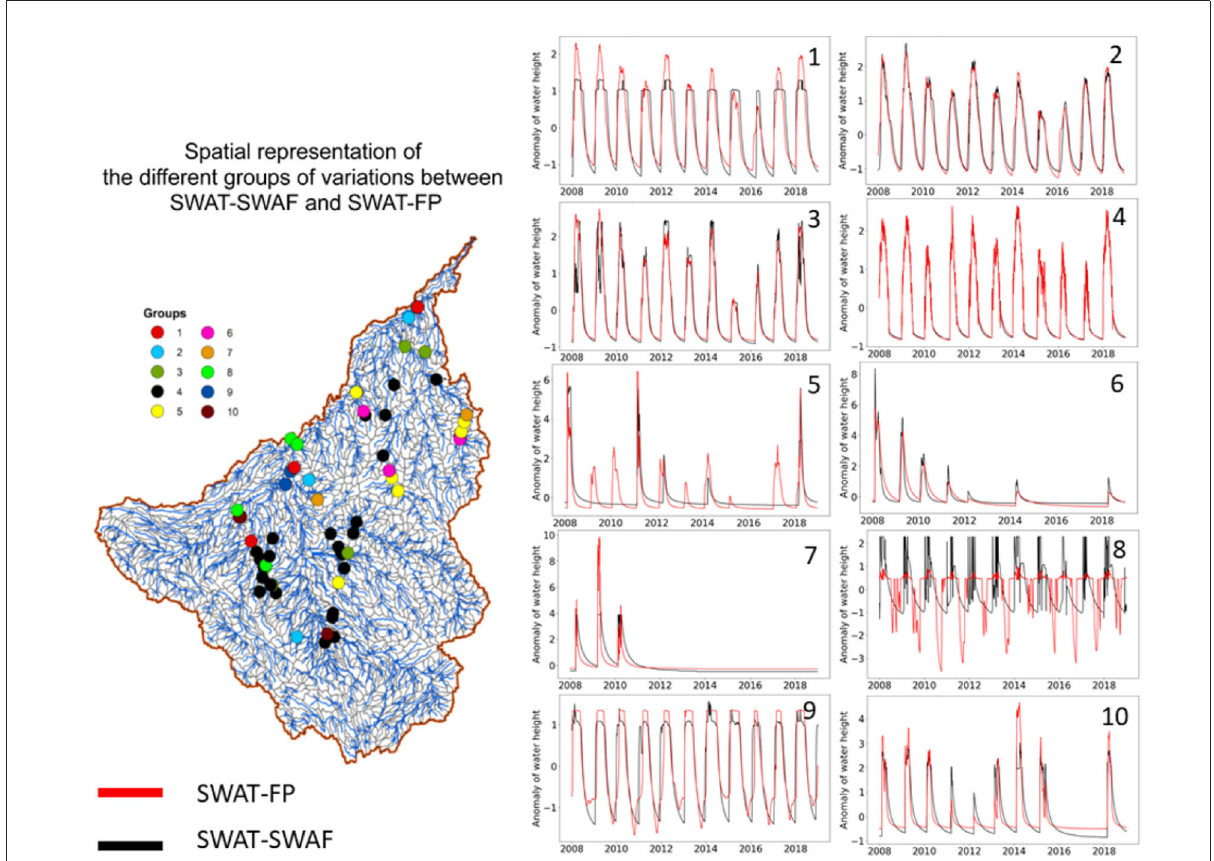
FIGURE10 (Left) Spatial representation of the different groups identified. Each color represents a unique group. (Right) Graphic description of the different groups identified regarding the variations of water height in floodplains between the two frameworks.